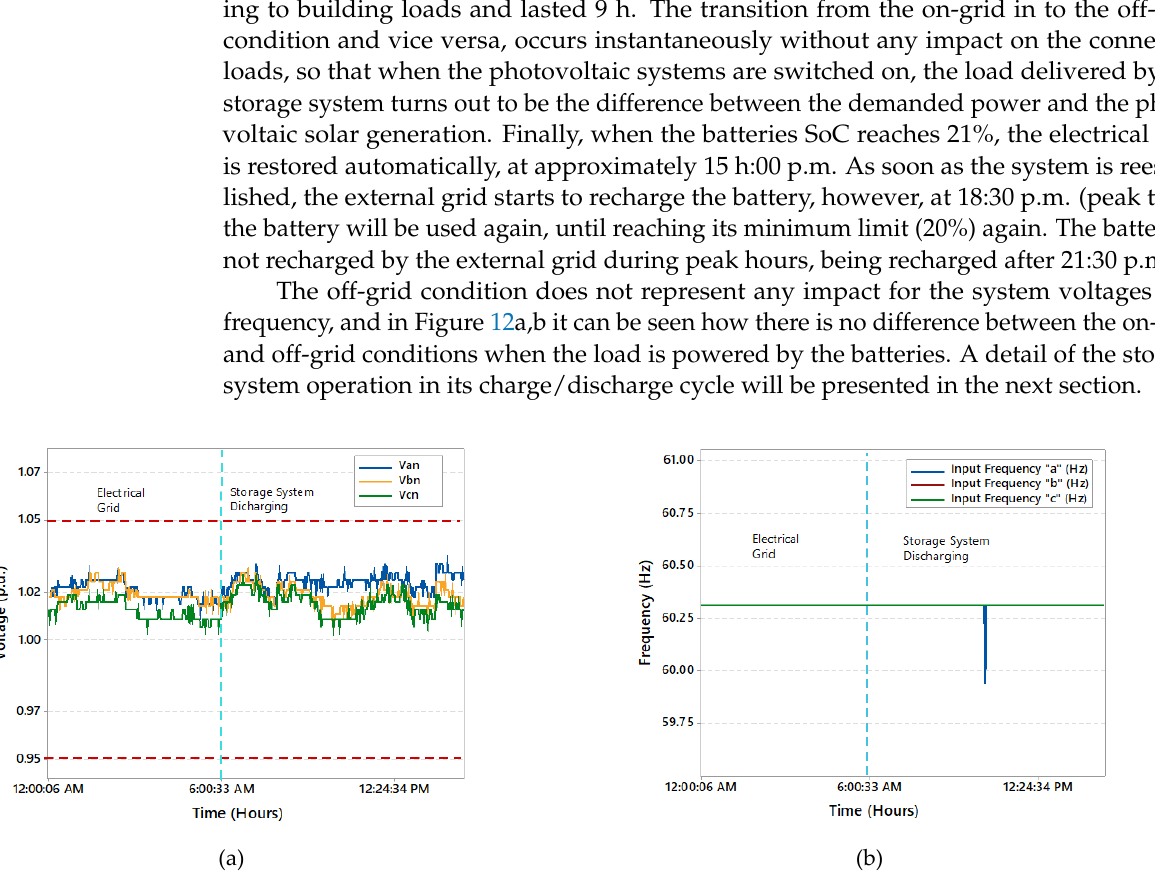
Figure 13. Storage system voltage discharging/charging cycle. As can be seen in Figure 13, the discharge and charge curves show some differences in voltage levels for the same battery SoC, within both charge and discharge curves, and the lowest voltage gap occurs at SoC = 27%, when the difference between charge and dis- charge voltage is 2.34 Volts. It also can be seen how the discharge cycle presents a random voltage variation, mainly due to the instability of photovoltaic generation and building loads demand variation. When a SoC = 21% is reached, the storage systems stop feeding the loads and the on-grid condition is restored. At this point the charging cycle starts with a 75 Amps charging current from the grid and PV systems until batteries are fully charged again, then the voltage decreases to the floating voltage value defined in 55 Volts (pink points), aiming to maintain the battery in fully charged state (trickle charging). By making a correlation between the voltage, the charge status and the power deliv- ered by the battery, through Figure 14a,b, it can be verified that when SoC < 55% and the